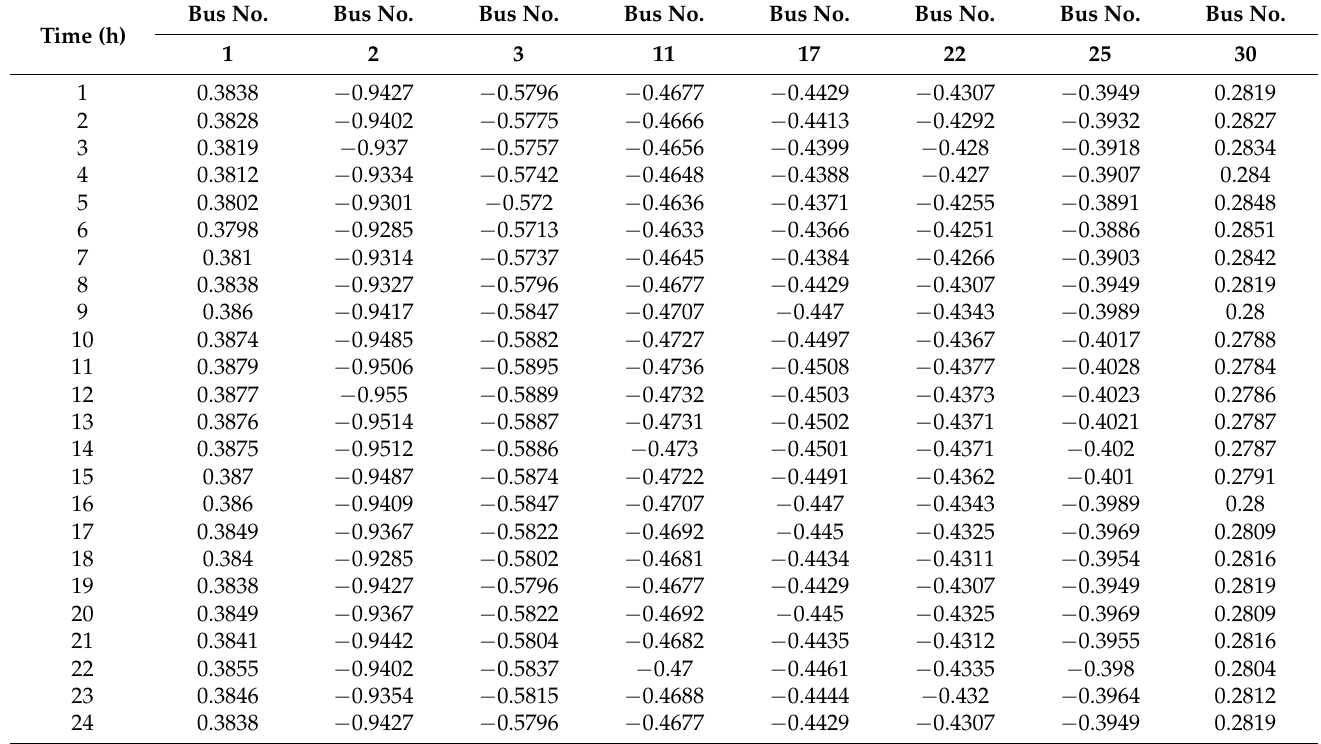
Table 1. BSF for some selected bus of modified IEEE 30 bus system.